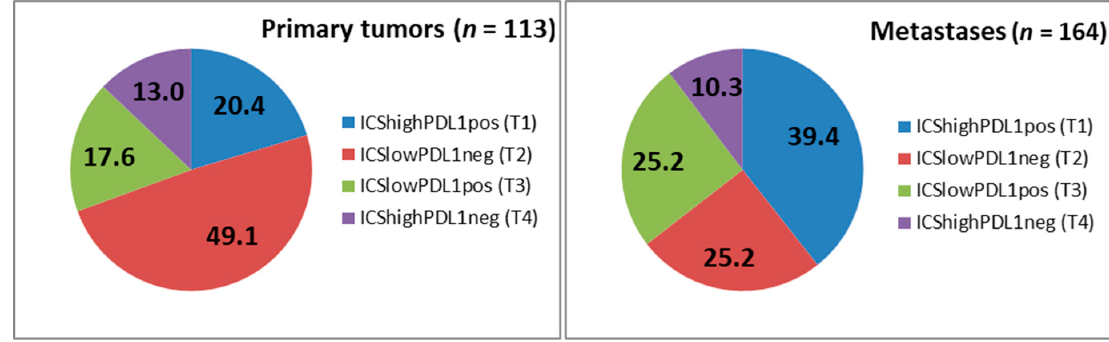
Figure 4. TIME classification of primary tumours and metastases. Subtypes are immunological ignorance; T1 (ICSlowPDL1neg), adaptive immune resistance; T2 (ICShighPDL1pos), tolerance; T3 (ICShighPDL1neg) and intrinsic induction; T4 (ICSlowPDL1pos). The values represent the percentage of each subtype. (ICS = Immune Cell Score).